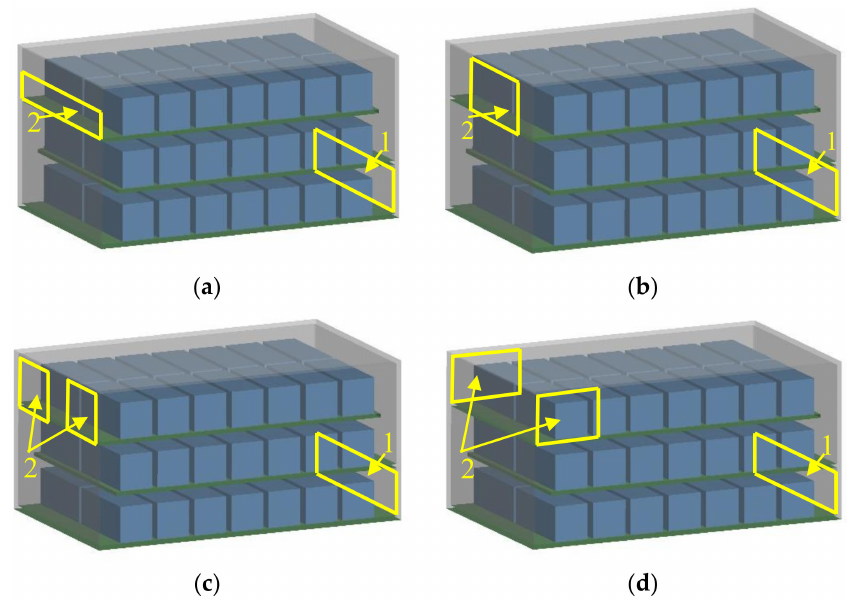
Figure 6. Schematic diagrams of the battery pack air outlet locations: ( a ) type I battery pack; ( b ) type II battery pack; ( c ) type III battery pack; and ( d ) type IV battery pack.